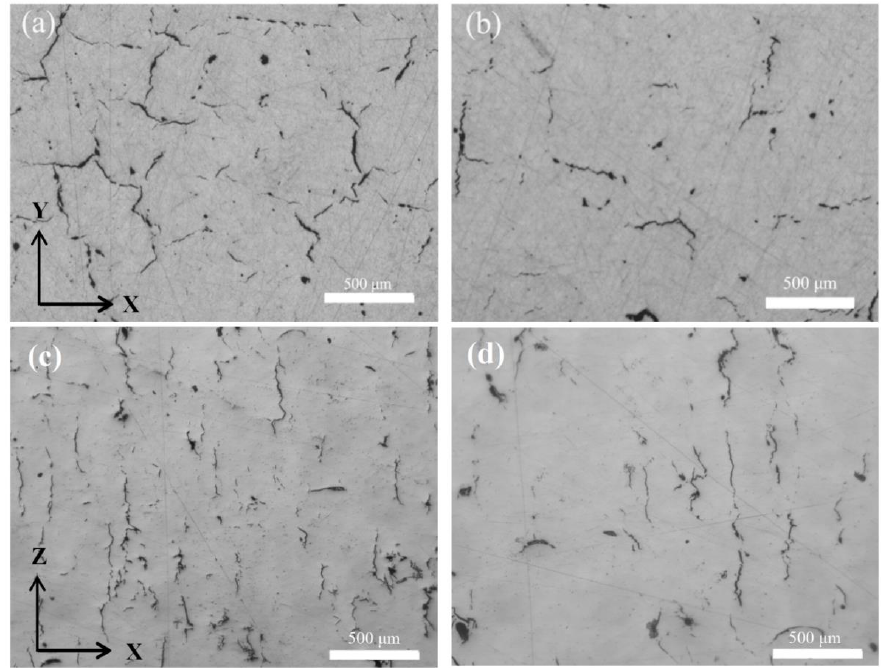
Figure 5. Light microscopy (LM) images showing the morphology of samples without (( a ) and ( c )) and with (( b ) and ( d )) support. These images showing two types of crack distribution—transverse